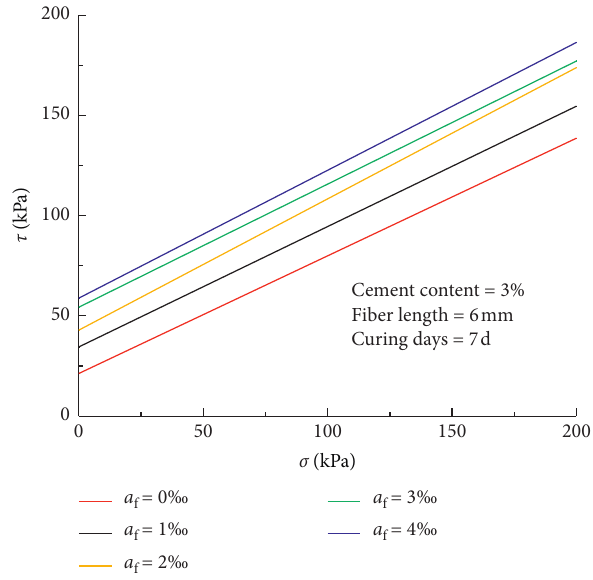
Figure 14: Mohr failure envelope.